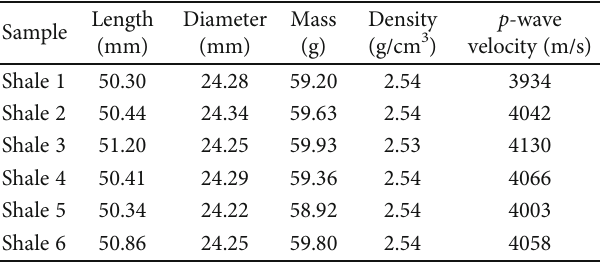
Table 1: Basic physical properties of the samples. Length Sample